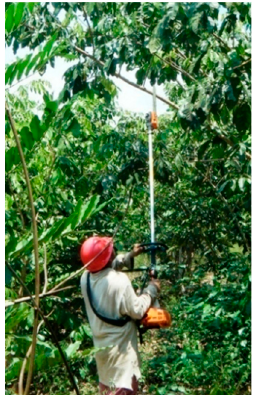
Figure 12. Pruning equipment to form crown.